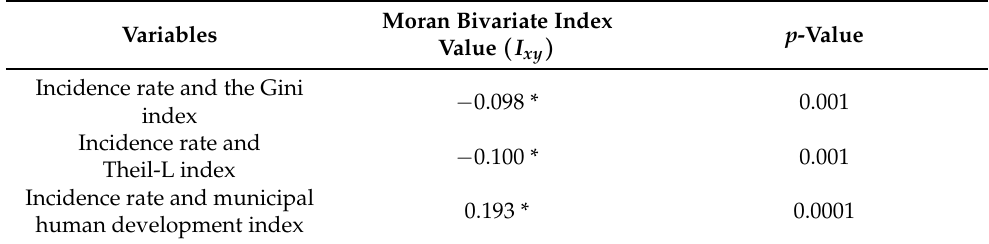
p -Value 0.001 0.001